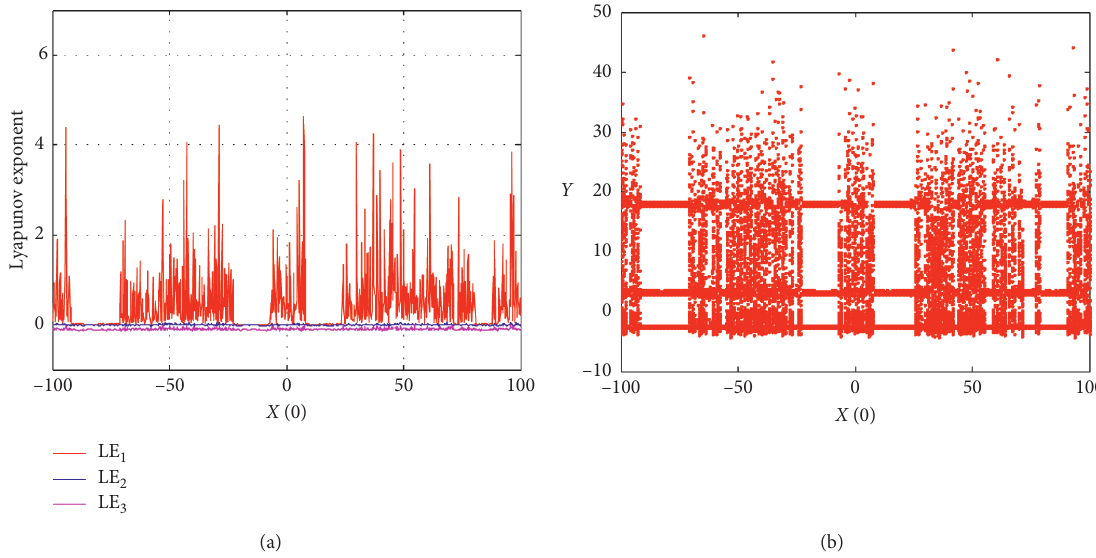
Figure 7: Dynamics with respect to the other initial condition X (0): (a) the first three LEs, (b) the bifurcation diagram of the state variable Y .